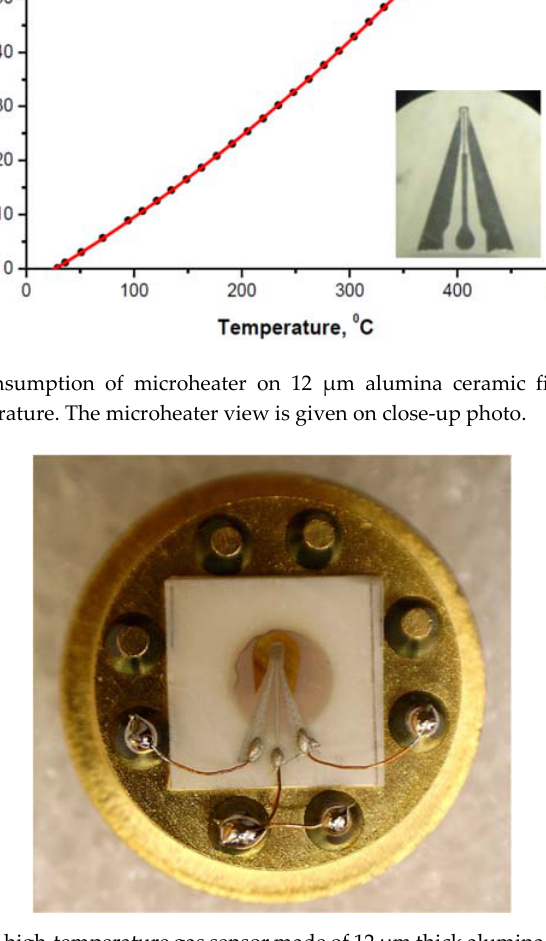
Figure 4. Full printed high-temperature gas sensor made of 12 μ m thick alumina. Power consumption is of ~80 mW (continuous heating up to 450 °C) and about 1 mW (pulsing heating with duty cycle of 1%). Cantilever-type sensor is adopted for autonomous and wireless gas